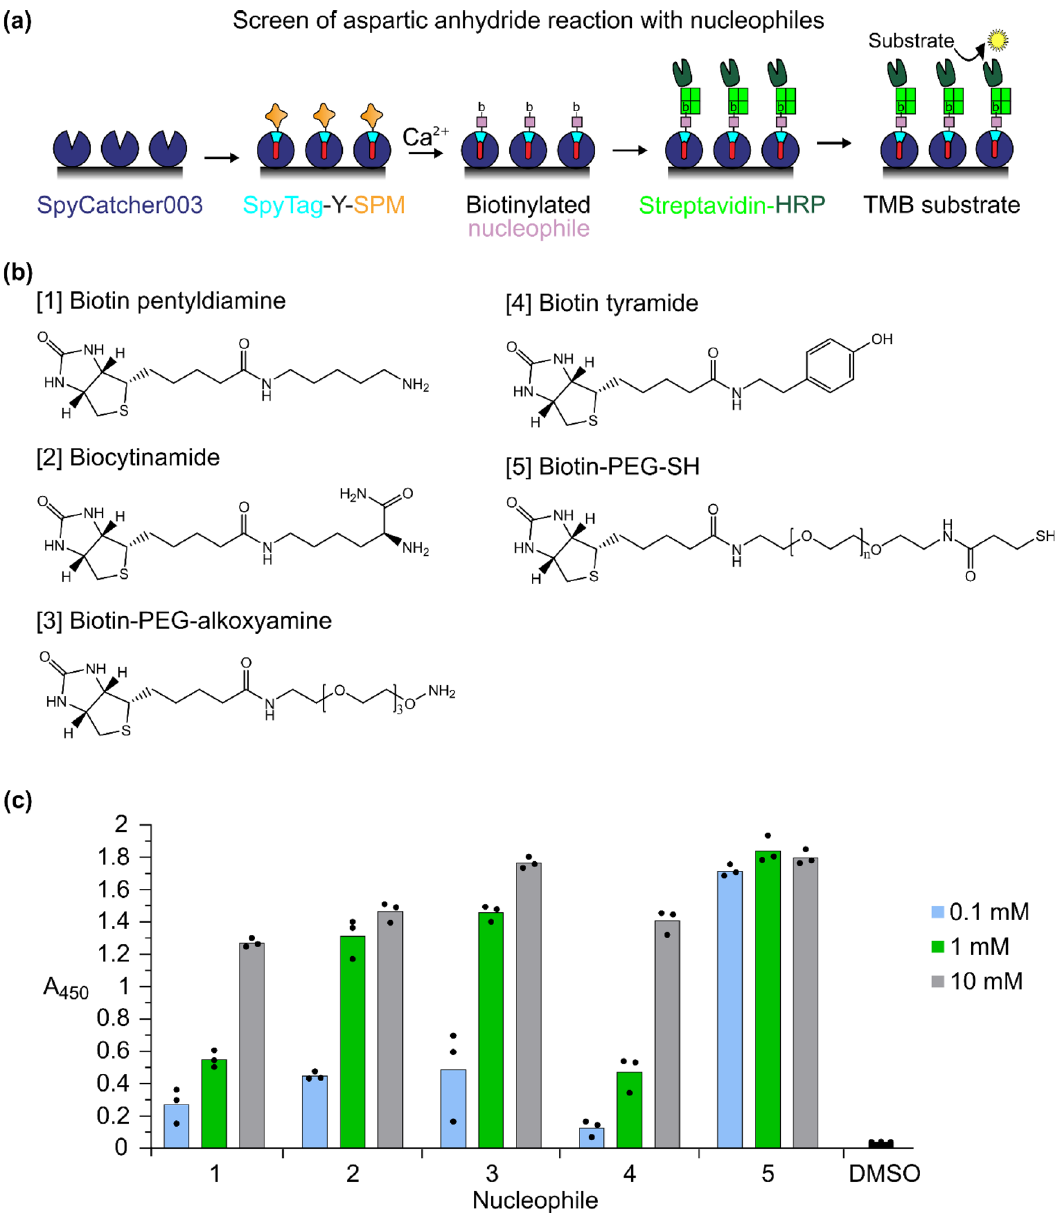
Fig. 5 Investigation of anhydride reactivity. a Schematic of assay for assessing anhydride reactivity. A SpyCatcher003 (dark blue) fusion is immobilized on a microtiter plate. SpyTag (cyan) linked to SPM (orange) forms an isopeptide bond (red) to SpyCatcher003. Ca 2 + promotes aspartic anhydride formation, allowing reaction with the biotin-linked nucleophile (lilac). Anchored biotin is detected using streptavidin-HRP (green). b Structure of biotin nucleophiles. c Nucleophile reactivity with anhydride. Nucleophiles at 0.1, 1, or 10 mM were incubated at 37 °C for 30 min in HEPES buffer pH 7.4 with Ca 2 + and conjugation was determined colorimetrically (mean and individual data points, n = 3). The buffer control consisted of 10% (v/v) DMSO in buffer in place of the nucleophiles. Source data are provided as a Source Data fi